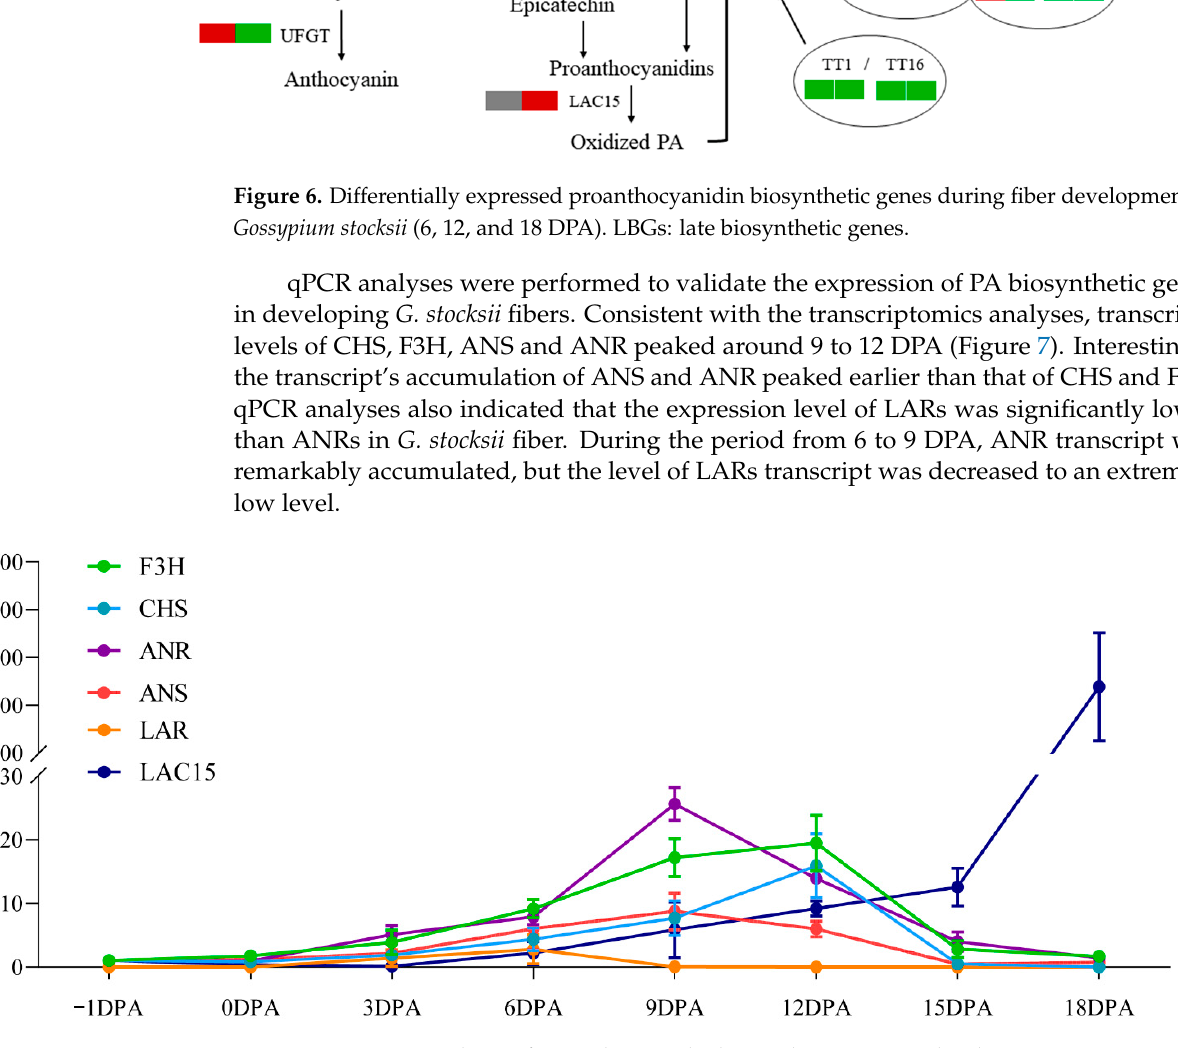
Figure 7. qRT-PCR analyses of proanthocyanidin biosynthetic genes in developing Gossypium stocksii fibers ( − 1 to 18 DPA).